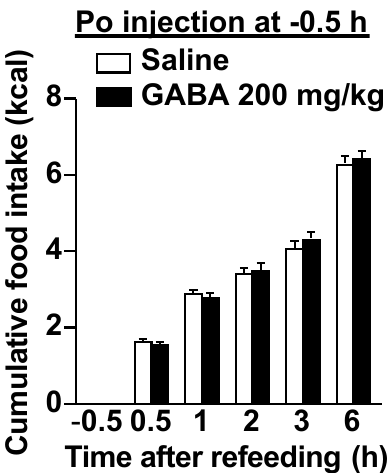
Figure 5. The preadministration of GABA 30 min before refeeding did not alter food intake. A single po administration of GABA at 200 mg/kg 30 min before refeeding failed to decrease food intake in overnight-fasted mice. n = 12. At − 0.5 h, the value of saline group is 0 and that of GABA is 0.0174 ± 0.000278 kcal, which are the energy values of the injected solution. po, peroral. GABA: Gamma- aminobutyric acid.